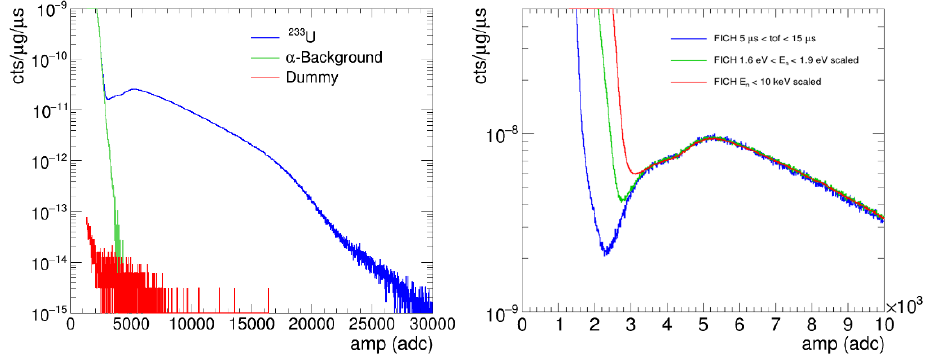
Fig. 6. Amplitude spectra of the fission chamber: various contributions for 0.02 eV < E n < 10 keV (left panel); α -FF separation for various conditions on E n or TOF (right